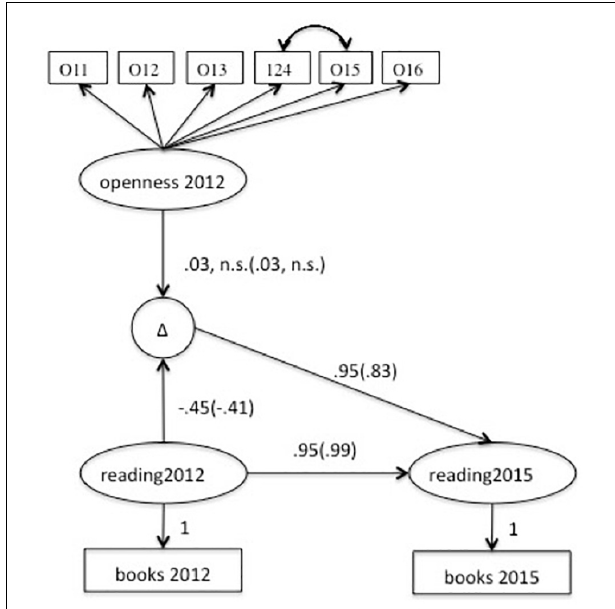
FIGURE 2 | Latent change score model of latent change in reading and the influence of Openness. (cid:49) , latent change in reading; O11–O26, items measuring openness in 2012 (loadings were left out). Non-standardized solution. Model including equal paths for